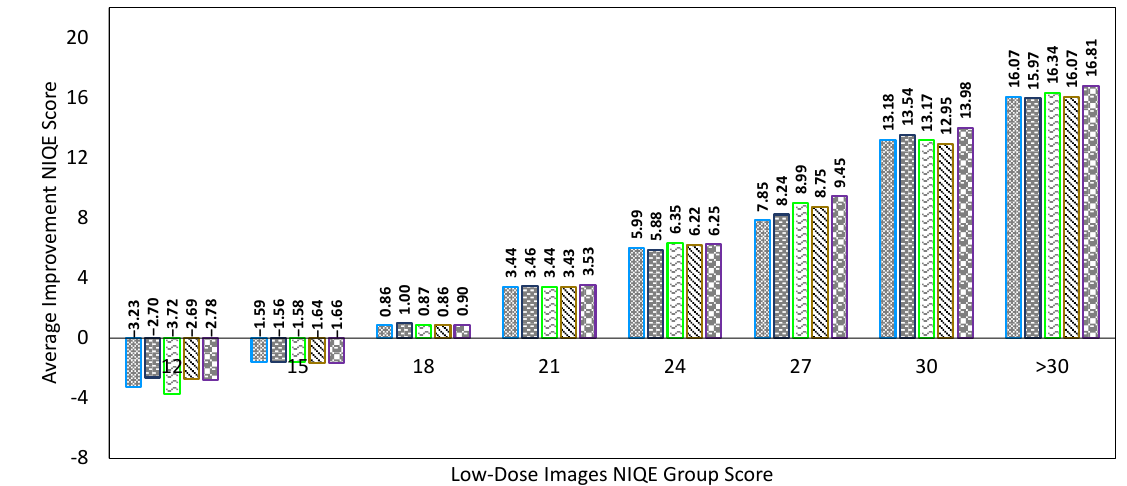
Figure 15. Comparison chart of NIQE scores from different CNN models with a new data set.